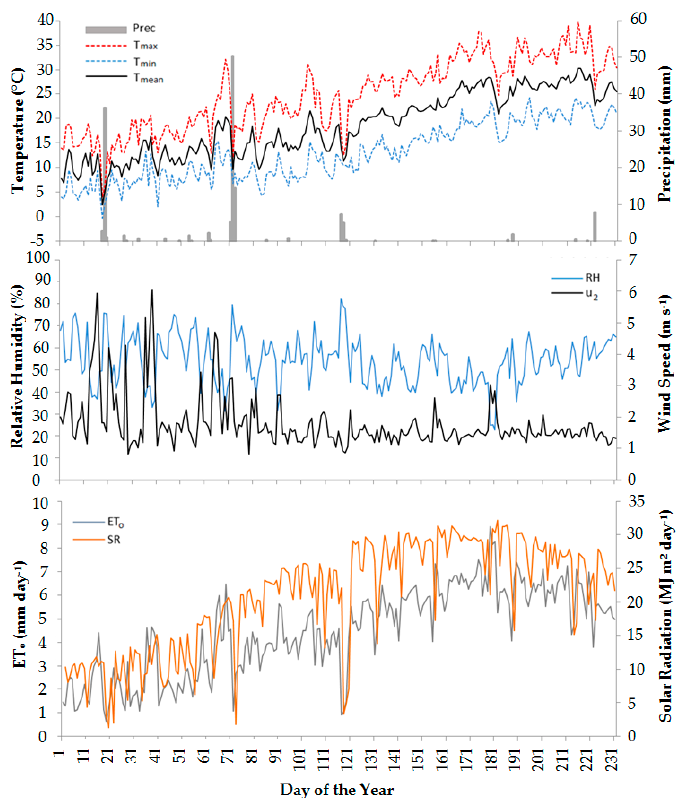
Figure 3. Daily weather data obtained from the weather station located at Molina de Segura, Murcia (code MO22; http://siam.imida.es) for the period including the peach growing season in 2017. Abbreviations: Prec = precipitation; T mean = mean temperature; T max = maximum temperature; T min = minimum temperature; RH = relative humidity; u 2 = wind speed; ET o = reference evapotranspiration; SR = solar radiation.